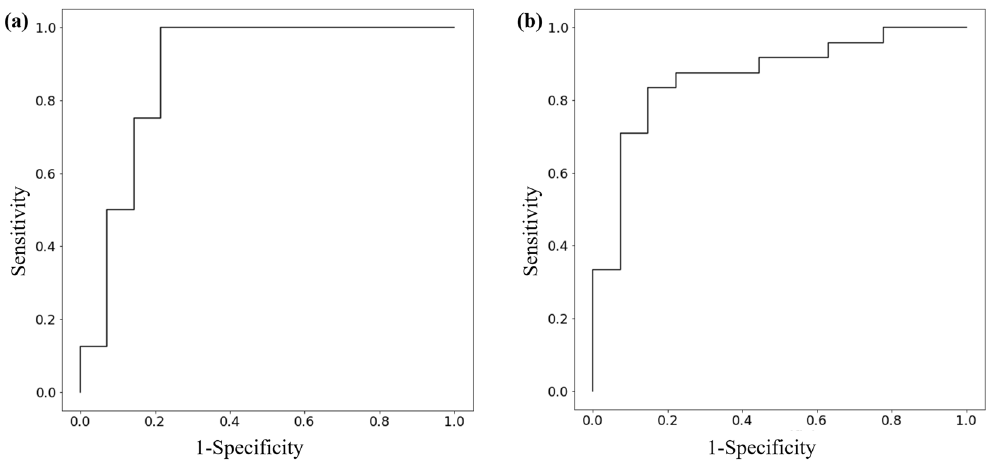
Figure 3. Receiver operating characteristic curves for the model predicting complete clinical success in (a) the test dataset (n = 22) and (b) the external cohort (n = 51).